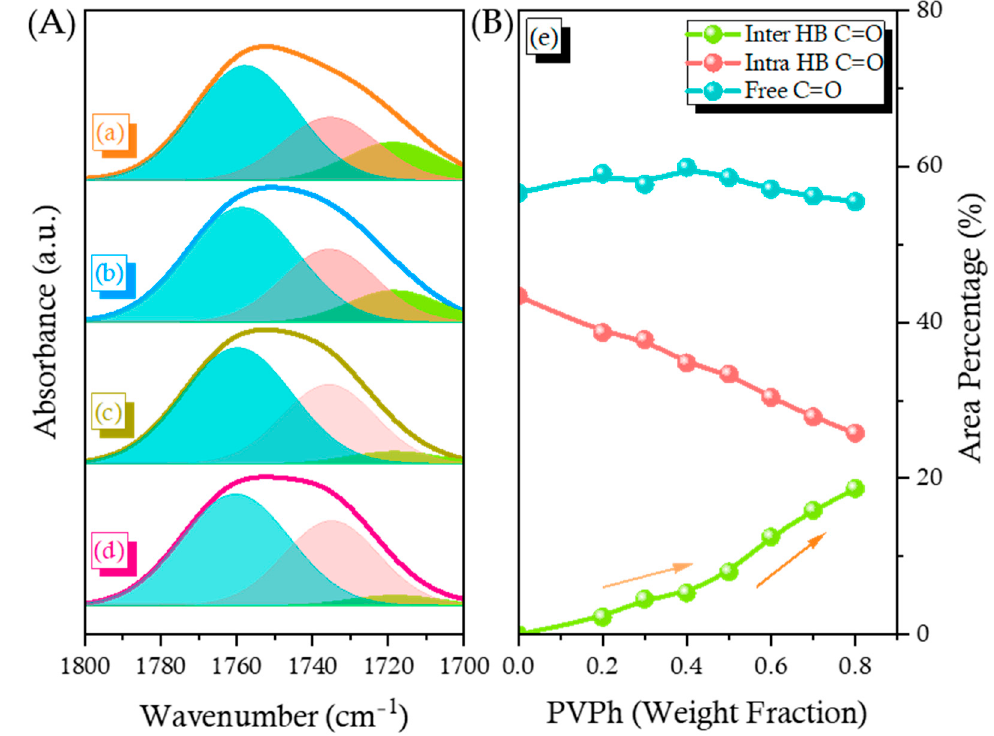
Table 1. The thermodynamic parameters of PVPh/PCHC binary blends at room temperature. Polymer